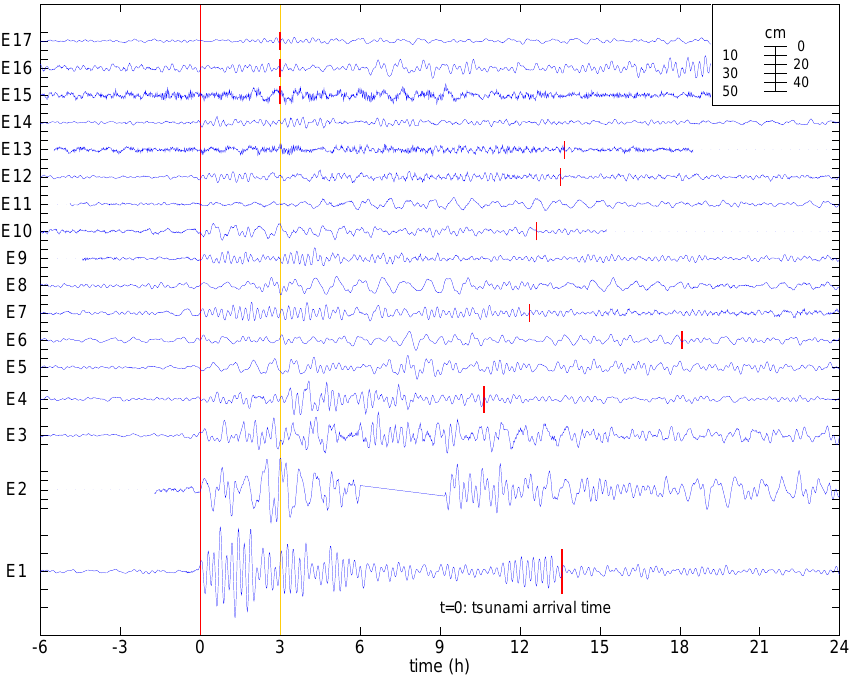
Fig. 5. Detided sea-level records of the 17 tsunami events analysed. Detiding was obtained through cubic splines fitting. The vertical red line at time 0 indicates the time of tsunami arrival, while the orange vertical line at time 3h indicates the end of the tsunami Detection Window DW. The subsequent red vertical segments in each record are the end of the tsunami signal. The interval comprised between the beginning and the end of the tsunami is designated as the Tsunami Interval TI. For some events TI is longer than